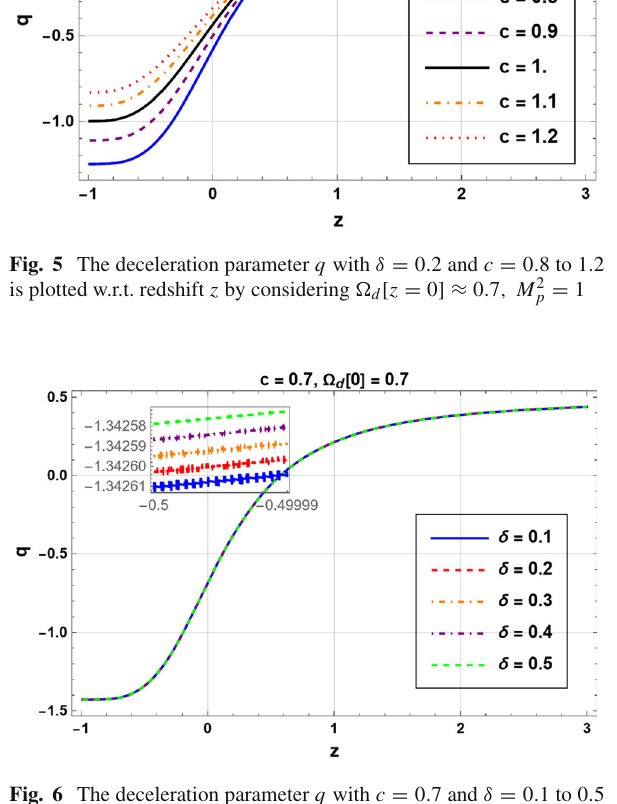
Fig. 6 The deceleration parameter q with c = 0 . 7 and δ = 0 . 1 to 0 . 5 is plotted w.r.t. redshift z by considering (cid:6) d [ z = 0 ] ≈ 0 . 7 , M 2 p =